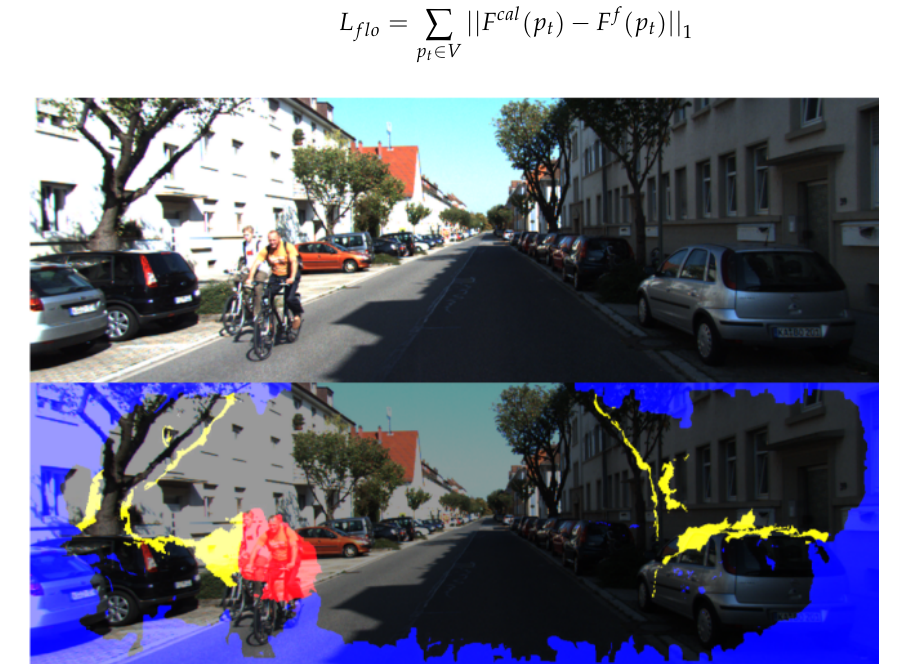
Figure 2. An example of a scene with the outlier region eliminated. The ( top ) scene is the original image while the ( bottom ) scene is the combination of the mask and image. According to the forward- backward consistency of the optical flow, all outlier regions are marked including occlusion regions (yellow), moving objects (red), boundaries and potential outliers (blue).